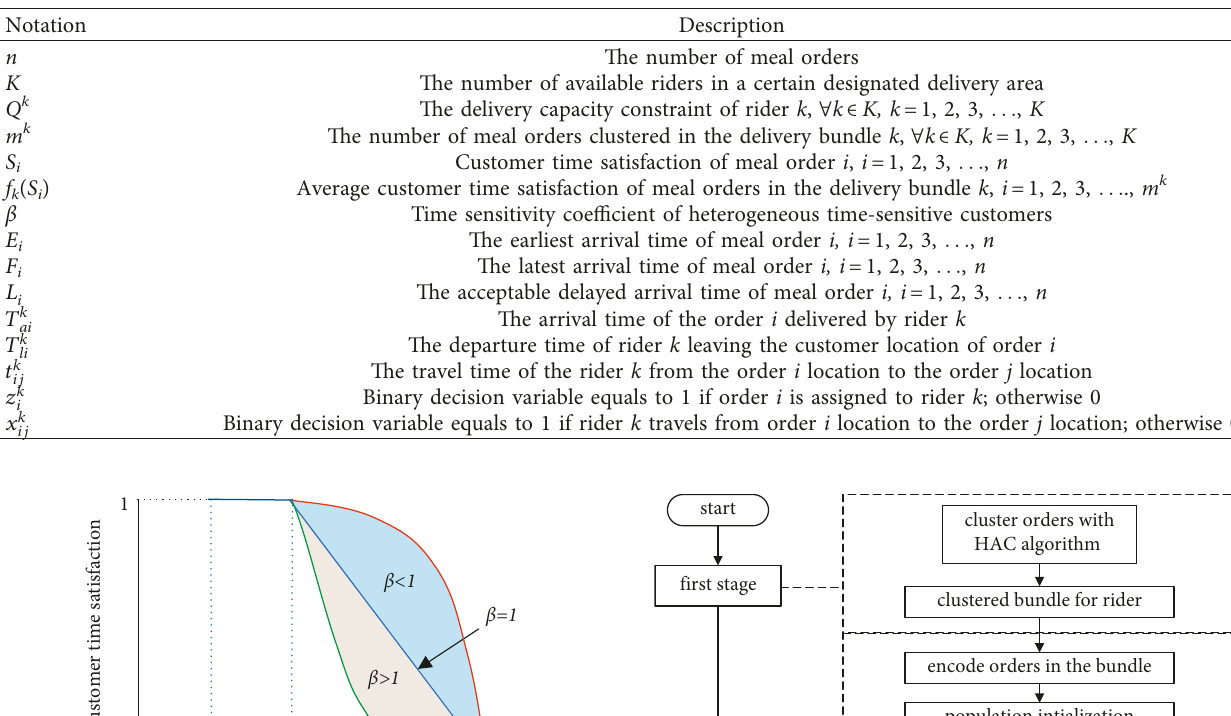
Table 2: Notations used in modelling.